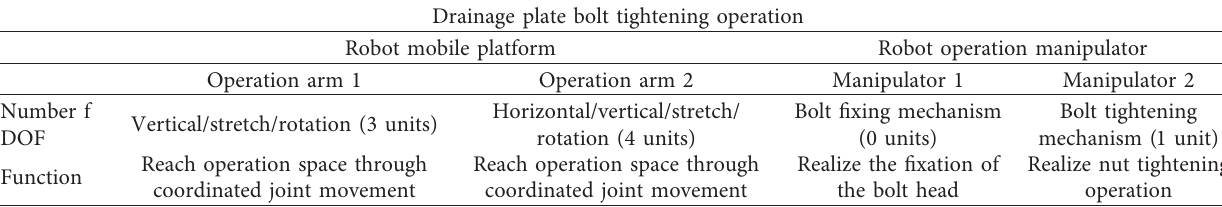
Table 2: Configuration analysis of the operation robot for drainage plate bolt tightening.